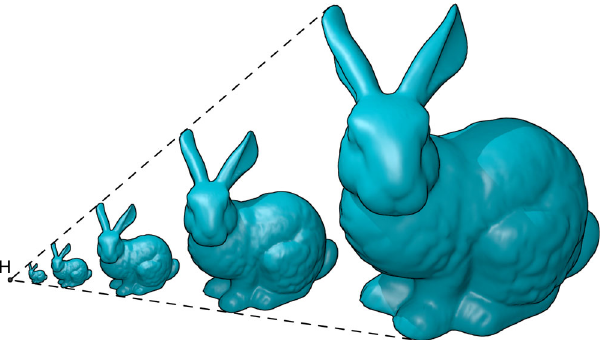
Fig. 1 Dilation of structures. Under dilation, a structure scales with respect to a homothetic center (point H in this fi gure), preserving its size and